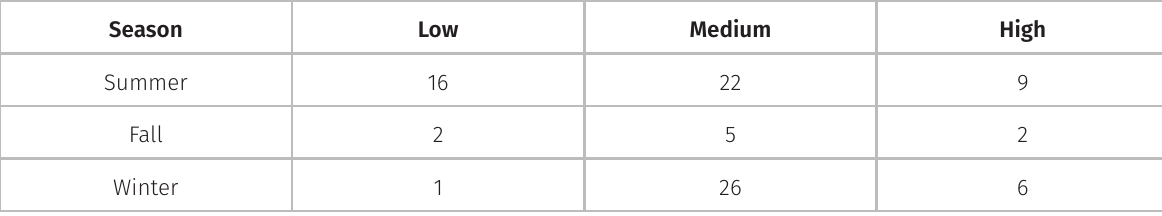
Table III. Common bottlenose dolphins, Tursiops truncatus truncatus , sighted during each season according to their degree of residence (low, medium and high) in Cabo Frio, RJ, Brazil. No recaptured individual was seen during